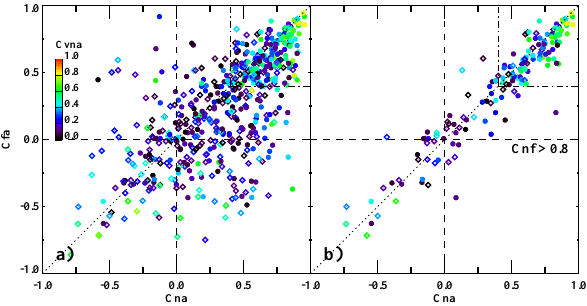
Fig. 9. The same as Figs. 6a and b but colour-coded in correlation coefficient between the STARE Norway velocity and IRIS absorp- tion, C vna